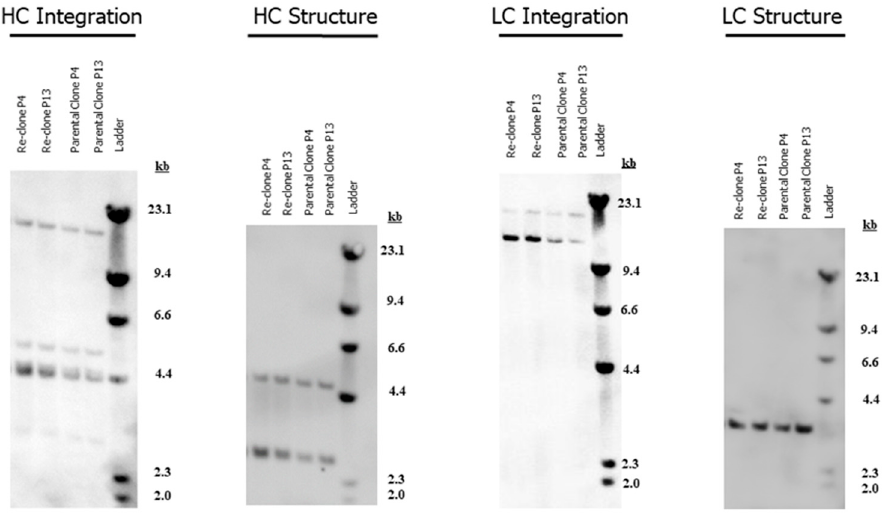
Figure 8. mAb3 genetic integration and structure analysis for the parental clone and re-clone. Southern blot analysis was used to determine the structural and integration profiles of the target HC and LC genes.